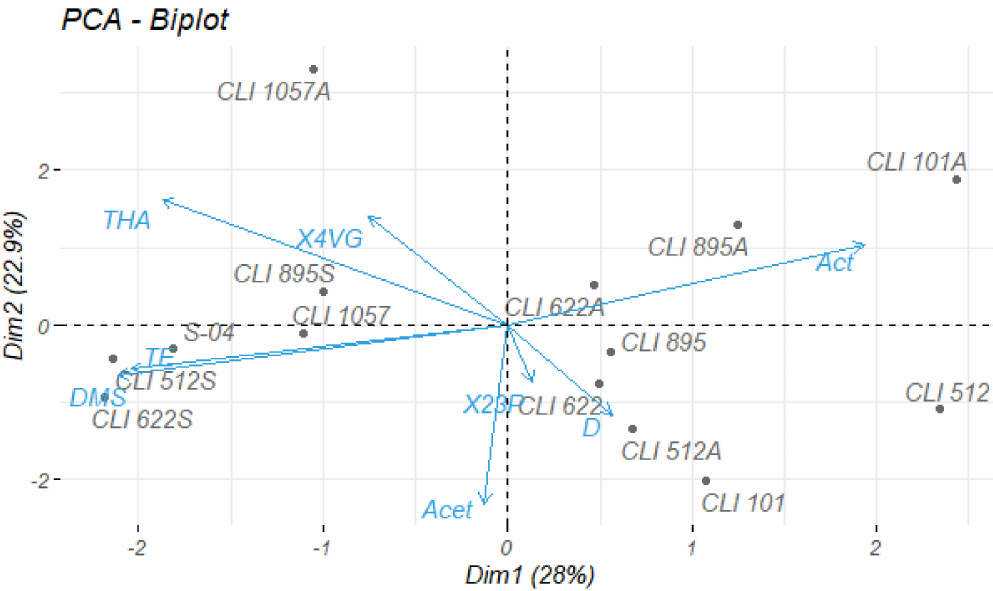
Figure 3. Projection of the beers on the axes formed by the principal components 1 and 2. Each object is the average of the two corresponding experimental beers. Act, acetaldehyde; DMS, dimethyl sulfide; Acet, acetone; D, diacetyl; X23P, 2,3-pentanedione; THA, total higher alcohols, TE, total esters; X4VG, 4-vinyl guaiacol. Yeast strains followed by A are related to fermentation with aeration, followed by S are related to sequential fermentation, and with no letter are related to pure